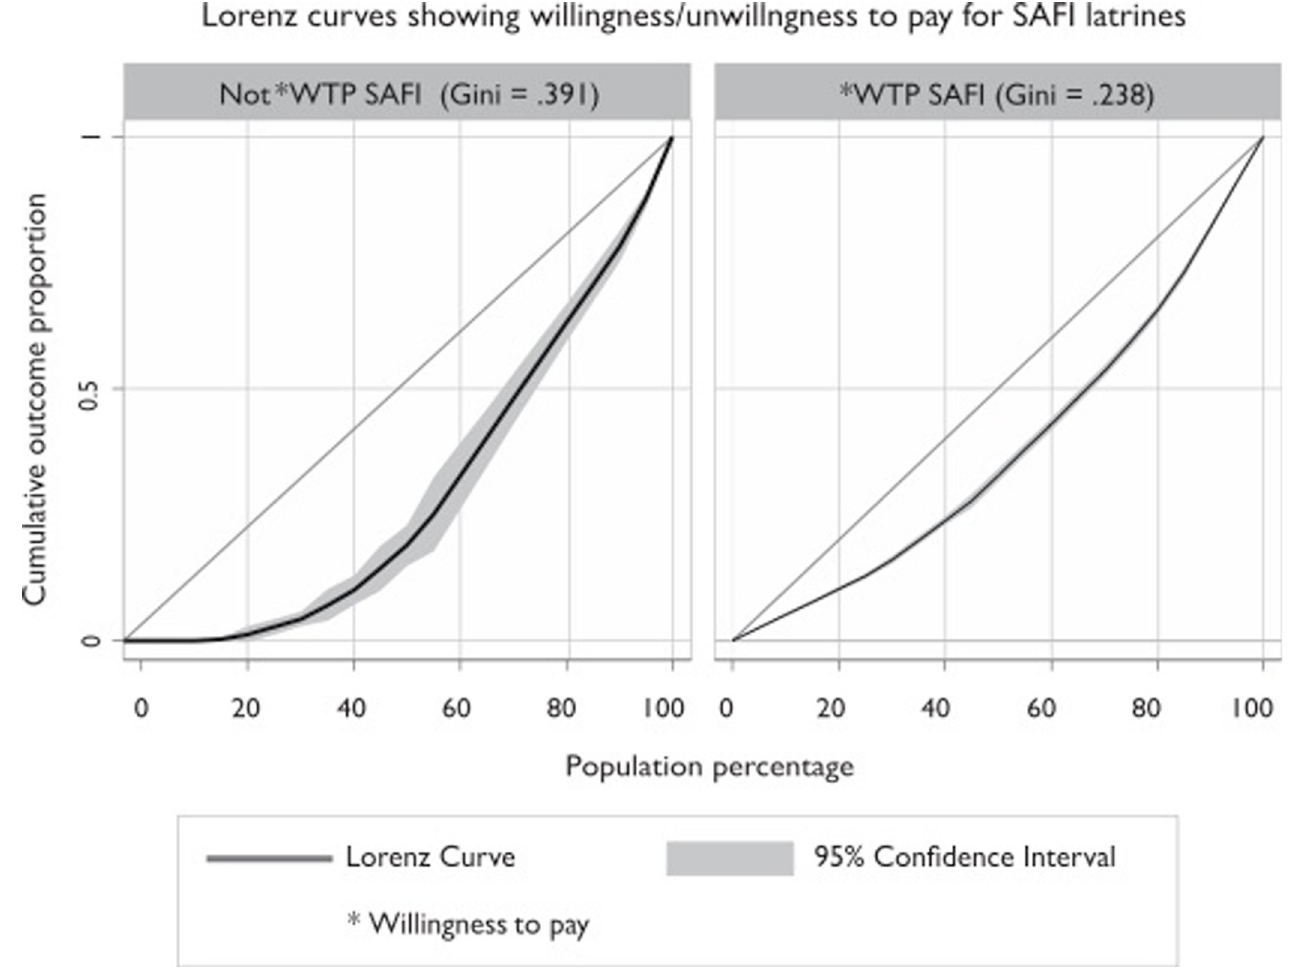
Fig 5. Lorenz curves comparing inequality ratios amongst households in the study